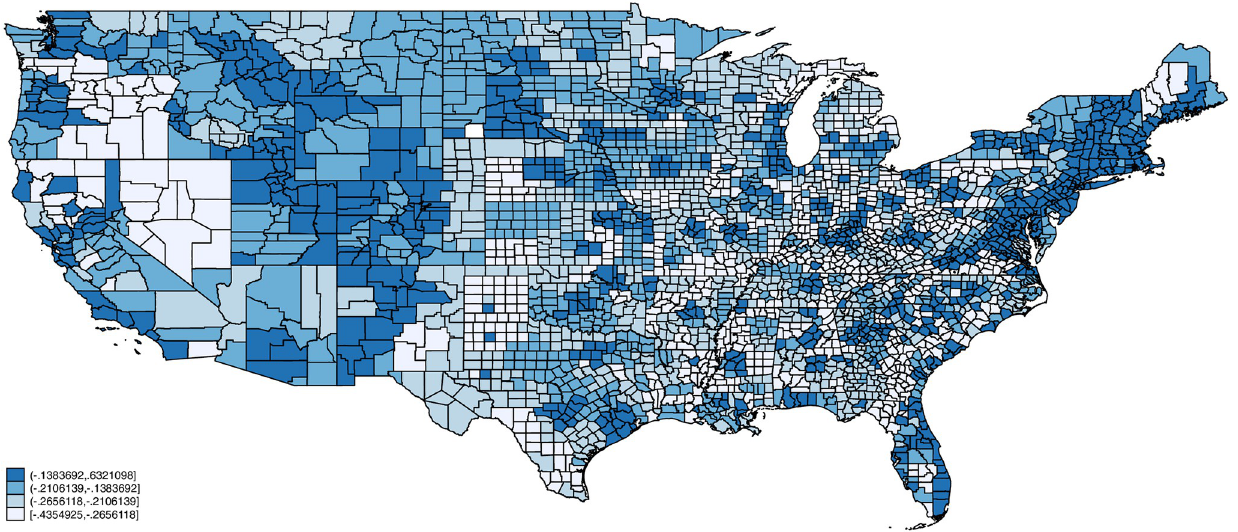
Fig 5. Remote workers by county. Notes: Each county is assigned the average value of the remote worker index based on the distribution of employment across occupations using 2018 American Community Survey (ACS) data. Endpoints correspond to quartiles. Person weights from the ACS are used.